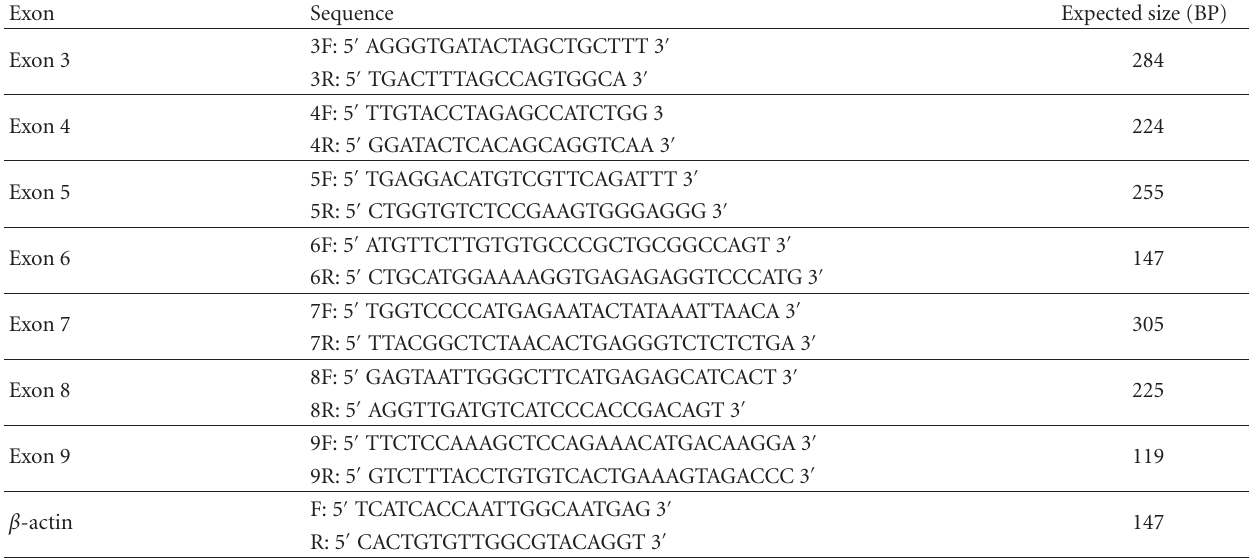
Table 2: Sequence of primers used in this